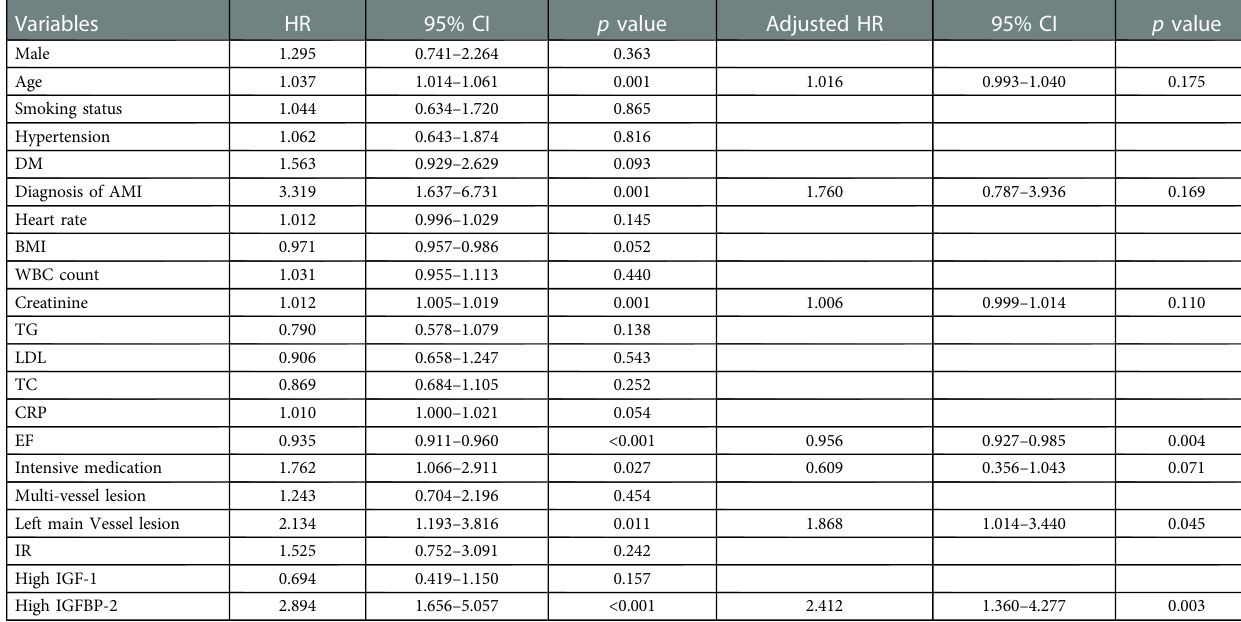
TABLE 5 Cox proportional hazard analysis for predictors of MACEs.